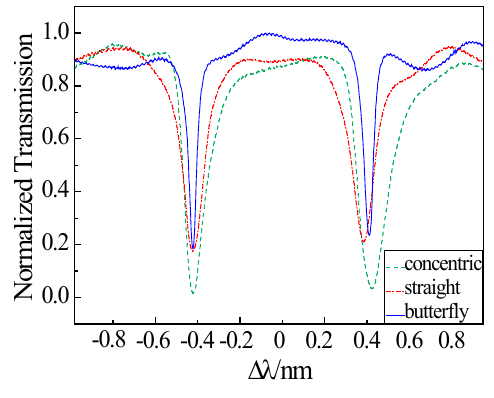
Figure 7. Resonance spectrum of output ports.